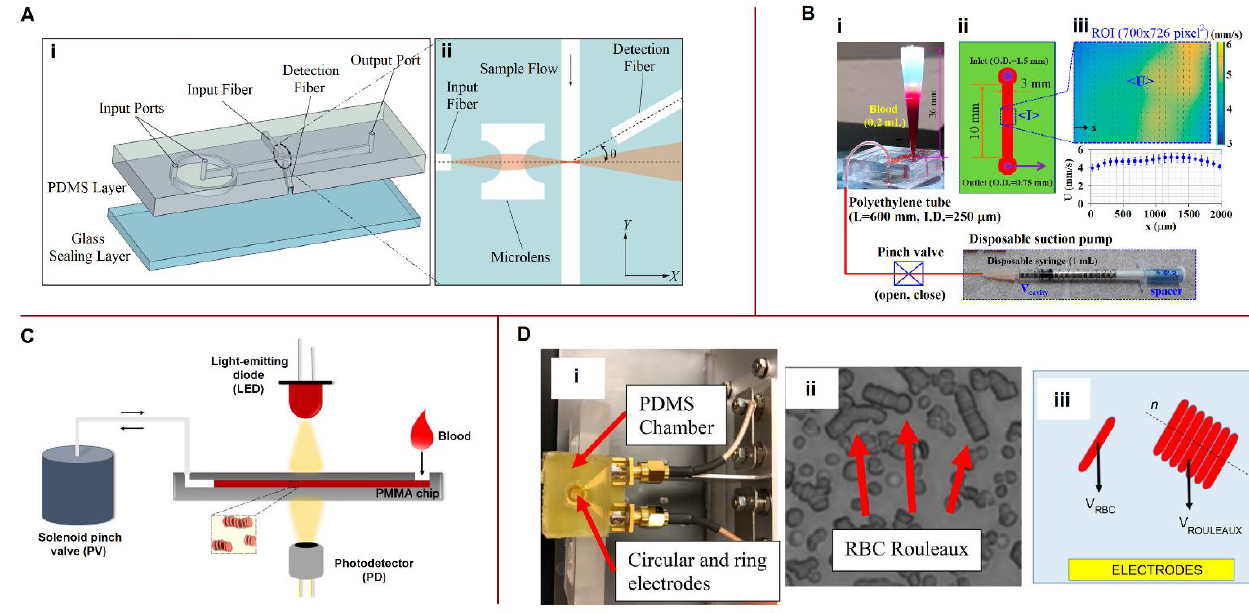
Figure 6. Systems for optical characterization of blood properties. ( A ) On-chip optical system for counting RBCs and PLTs: ( i ) Assembly of the microfluidic chip. ( ii ) Schematic of the optical systems. ( iii ) Microscopic image of on-chip integrated optics. Reproduced with permission from [131]. Copyright 2016, the author(s). ( B ) Measurement of RBC aggregation under periodic on–off blood delivery: ( i ) Schematic of the experimental setup: a suction pump and a microfluidic device with a pipette tip. ( ii ) Microfluidic channel. ( iii ) Averaged blood velocity and averaged image inten- sity. Reproduced with permission from [79]. Copyright 2017, the author. ( C ) Microfluidic system used for ESR measurement: Solenoid pinch valve used to disaggregate RBCs. Reproduced with permission from [132]. Copyright 2017, Springer-Verlag Berlin Heidelberg. ( D ) EIS of blood during sedimentation: ( i ) Photographic image of the experimental setup. ( ii ) Microscopic image of RBC rouleaux formation. ( iii ) Schematic cross-sectional view of the chamber. Reproduced with permission from [133]. Copyright 2021, the